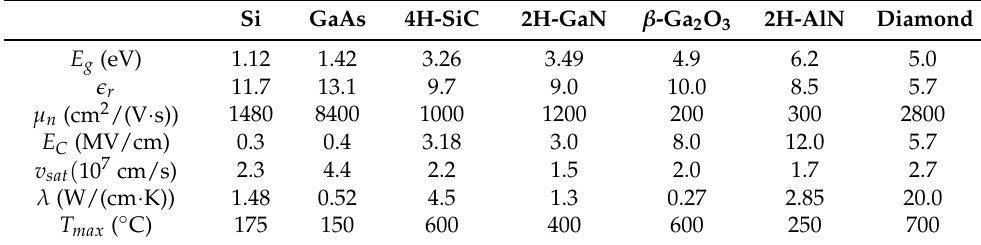
Table 2. Main physical properties of different semiconductor materials [54,146,147].